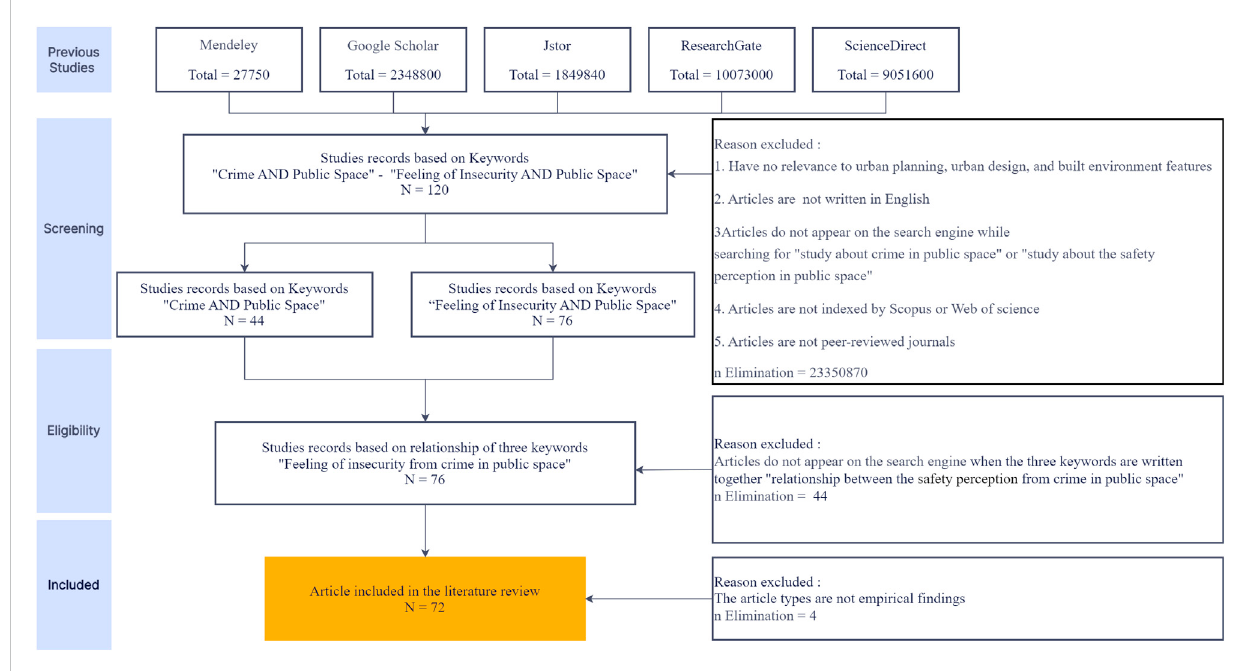
FIGURE 1 PRISMA fl owchart showing how articles are sorted based on the used criteria using a systematic manual